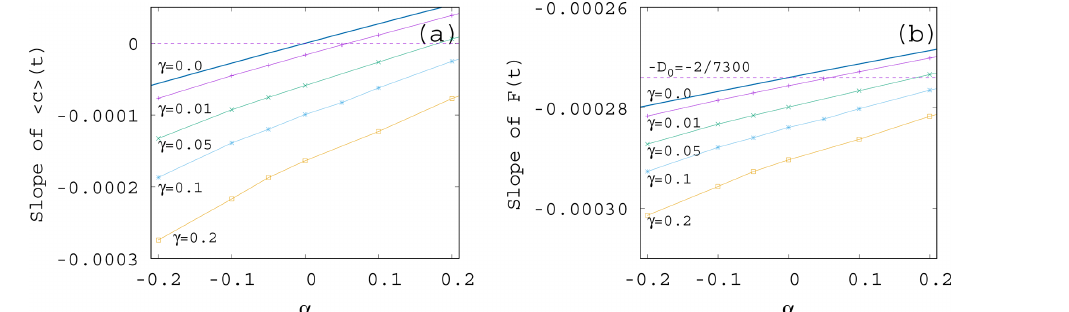
Figure 8. Slope (a) S of the ensemble-averaged phytoplankton concentration < c > ( t ) and (b) − D of the average forcing < F > for t > 0 as α is varied; data shown for various values of γ . The γ = 0 curve shows the α dependence of (a) S and (b) − D from Eqs. (11) and (12). Dashed lines mark the slopes for α = 0 and γ = 0.